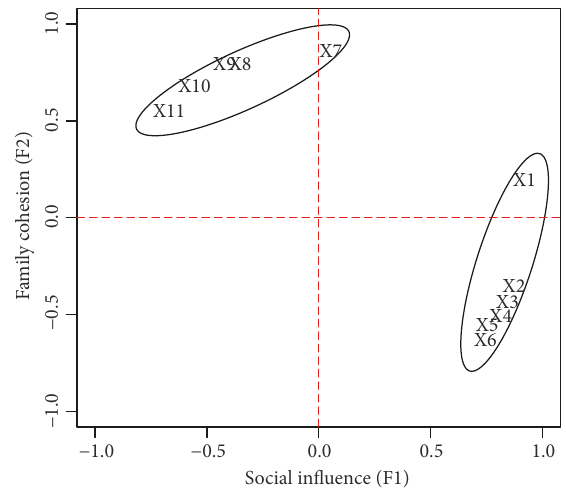
Figure 1: Factor loading